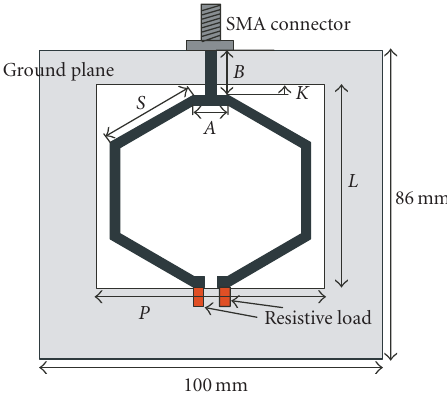
Figure 3: HMS antenna with rectangular